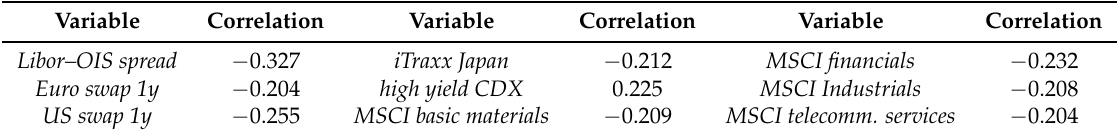
Table 9. Correlations with (cid:103) GRF